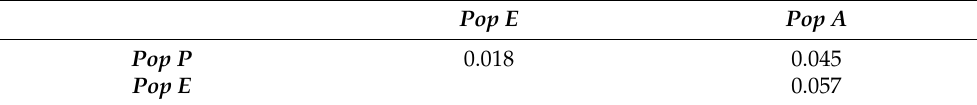
Table 2. M. globosa F st values comparing patients, breeders and animals genotypes.